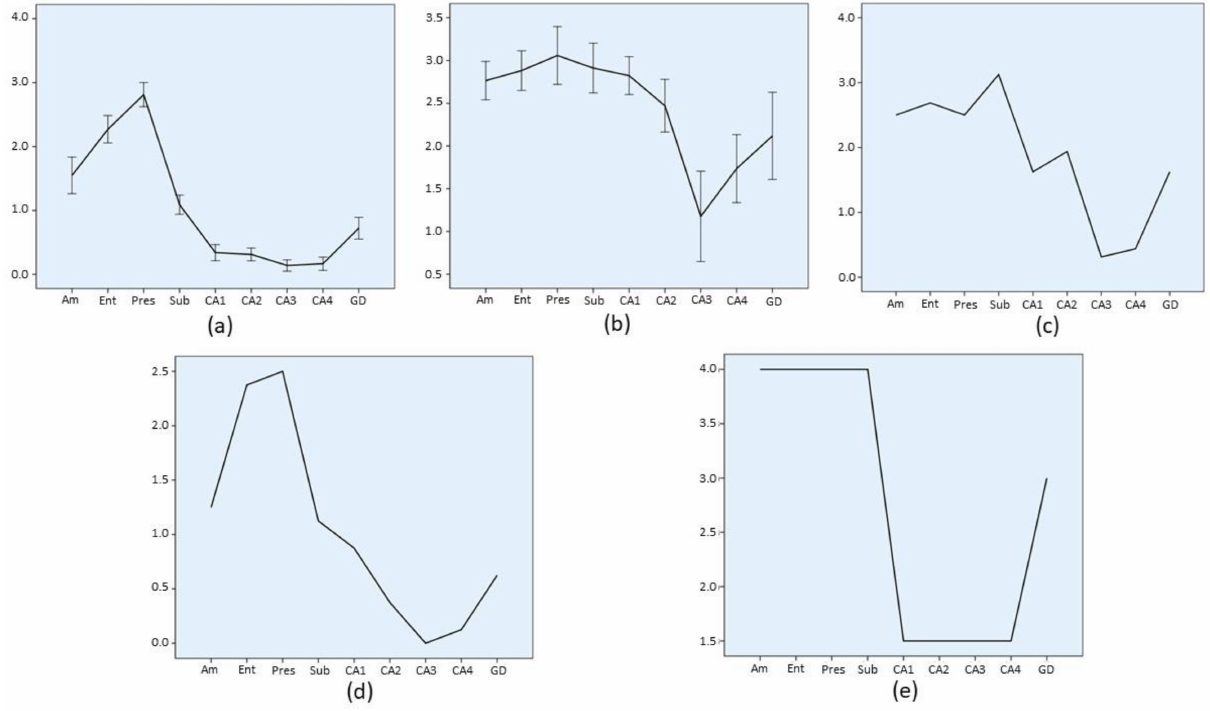
Figure 3. Regional profile of average involvement (Ai) intensity along the medial temporal lobe of sCJD histotype groups. Each group encompasses pure and mixed (PrP res 1 + 2a) phenotypes. Confidence interval bars (95%) are shown only for groups with n > 30. Note the different scale range of individual charts. ( a ) sCJD MM/MV1, ( b ) sCJD VV2, ( c ) sCJD MV2K, ( d ) sCJD MM/MV2C, and ( e ) sCJD VV1. Am : amygdala; Ent : entorhinal cortex; Pres : presubiculum; Sub : subiculum; CA1 , CA2 , CA3 and CA4 : CA Sommer’s sectors of the hippocampus; GD : dentate